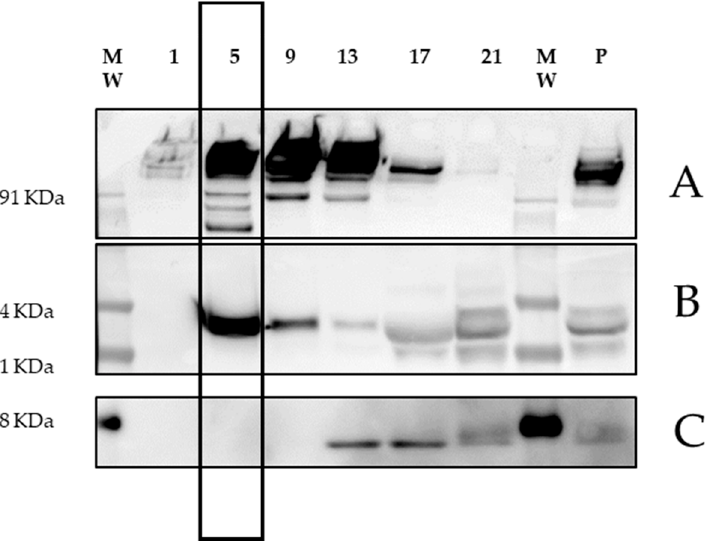
Figure 5. Analysis of OptiPrep fractions . Representative immunoblotting of ApoB ( panel A ), PCSK9 ( panel B ) and Apo AI ( panel C ) of the pooled OptiPrep fractions. MW: Prestained protein standard; 1: POOL 1-3; 5: POOL 5-8; 9: POOL 912; 13: POOL 13-16; 17: POOL 17-20; 21: POOL 21–24; P: plasma. PCSK9 peak in LDL (fractions 5–8) corresponds to the highlighted